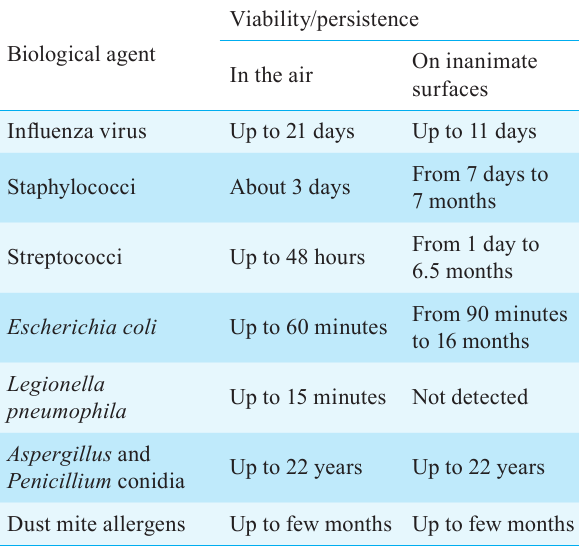
Table 2 Viability of microbial particles in the air and on sur-